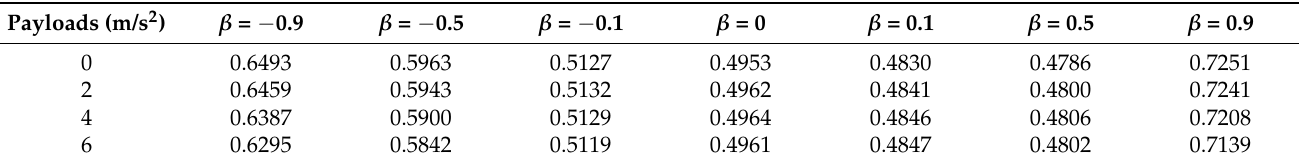
Table 3. Root mean squared error (RMSE) of the simulated tracks under different payloads and different fractional orders in the proposed controller.